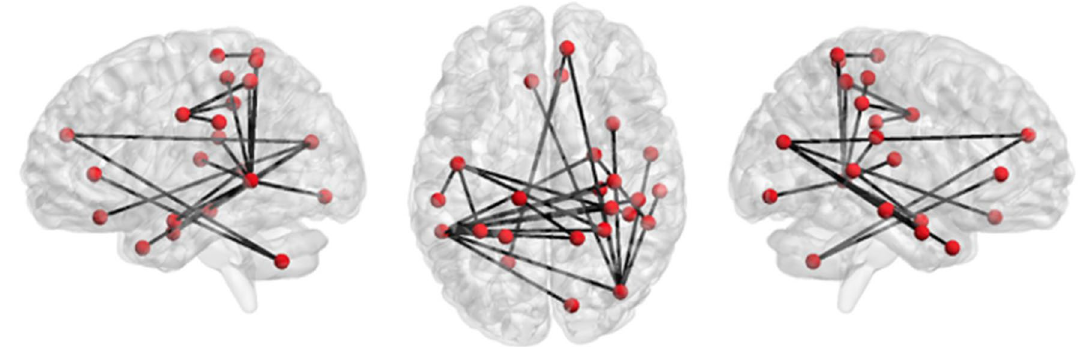
Figure 2. Comparison between session 1 and 4 across the whole sample. The NBS results showed increased connectivity between fronto-parietal regions in the right hemisphere and between left temporal and right parietal regions (Table